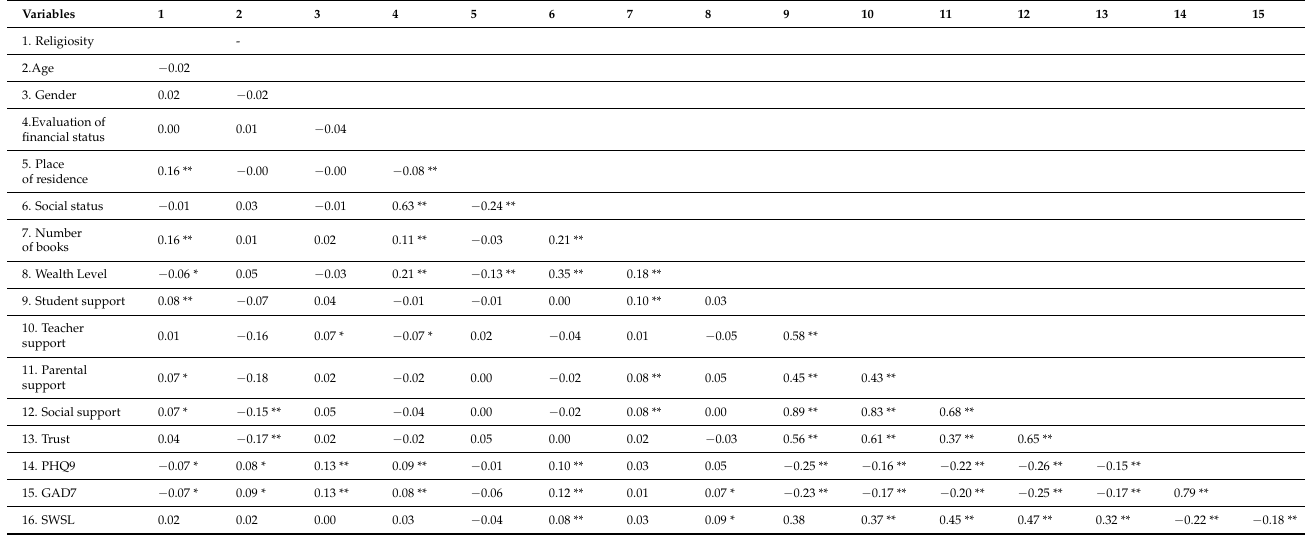
Table 4. Correlation coefficients among all predictors